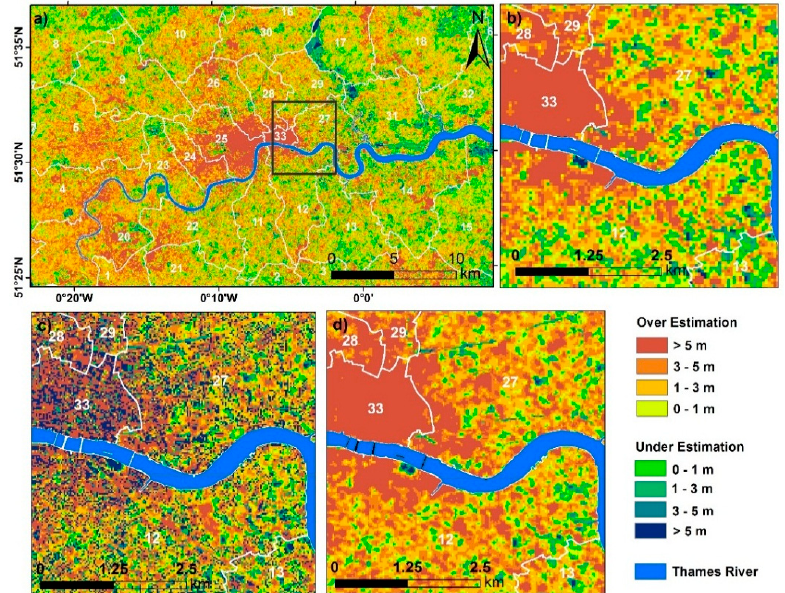
Figure 10. Location of overestimated and underestimated elevation pixels in SRTM DEM compared to ( a ) 50 m DEM with square box shown in detail in ( b ), ( c ) 1 m DEM, and ( d ) 5 m DEM.